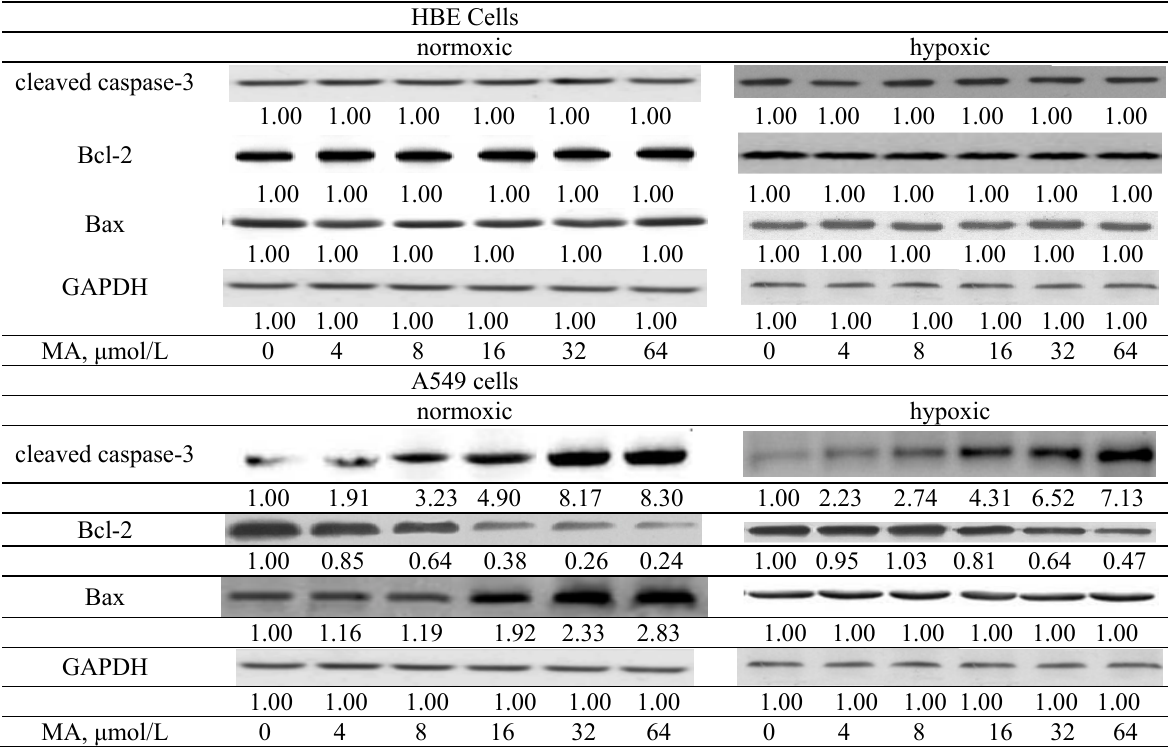
Figure 2. Effects of MA at 0, 4, 8, 16, 32 or 64 μ mol/L upon cleaved caspase-3, Bcl-2